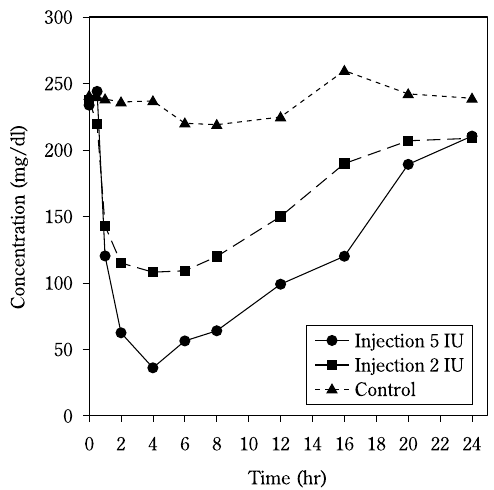
Fig. 6 Effects of Hypodermic Injection on Blood Glucose Level in